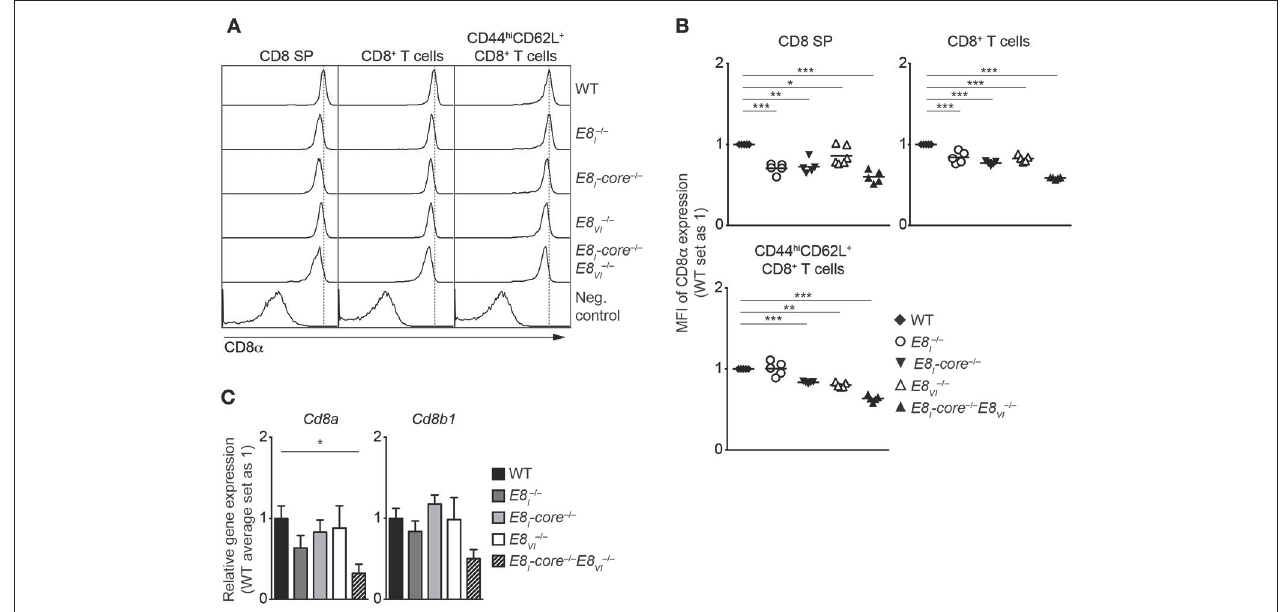
FIGURE 4 | E8 I - core and E8 VI synergistically regulate CD8 expression in cytotoxic lineage cells. (A) Histograms depict CD8 α expression on CD8SP thymocytes, splenic CD8 + and CD8 + CD44 hi CD62L + T cells isolated from wild-type (WT), E8 I − / − , E8 I - core − / − , E8 VI − / − and E8 I -core − / − E8 VI − / − mice. The gating strategy is shown in Figures S4B,D . Dotted vertical lines indicate the peaks of CD8 α expression on WT cells. CD8 α expression on WT CD4SP thymocytes (left panel) or CD4 + T cells (middle and right panels) is shown as negative staining controls. (B) Diagrams showing the relative mean fluorescence intensity (MFI) of CD8 α expression on CD8SP thymocytes (left), splenic CD8 + (middle) and CD8 + CD44 hi CD62L + (right) T cells isolated from wild type (WT), E8 I − / − , E8 I - core − / − , E8 VI − / − , and E8 I -core − / − E8 VI − / − mice. Data obtained from the analysis of WT, E8 I − / − , E8 I - core − / − and E8 VI − / − mice (already shown in Figures 2B , 3B ) were included in the respective diagrams. The MFI values of WT cells are set as 1. Each dot represents one mouse. Horizontal bars indicate mean values. A one-sample t -test was performed for statistical analysis, where the values obtained from each group of the mutant mice were compared to the WT ones (i.e., 1). Only the comparisons that reached statistically significant levels (i.e., p < 0.05) are indicated in the diagrams. (C) qRT-PCR analysis showing Cd8a (left) and Cd8b1 (right) gene expression levels (normalized to the Hprt gene expression levels) in wild-type (WT), E8 I − / − , E8 I - core − / − , E8 VI − / − and E8 I -core − / − E8 VI − / − naive CD44 lo CD62L + CD8 + T cells. The average expression levels in WT cells were set as 1. Error bars indicate SEM. A one-way ANOVA analysis followed by Tukey’s multiple-comparison test was performed for statistical analysis. (B,C) The p -values were defined as following: *, p < 0.05; **, p < 0.01; ***, p < 0.001. Data are representative (A) or show the summary (B,C) of 5–6 mice (A,B) or 4–5 independent biological samples (C) analyzed in 5 (A,B) and 5 (C) independent